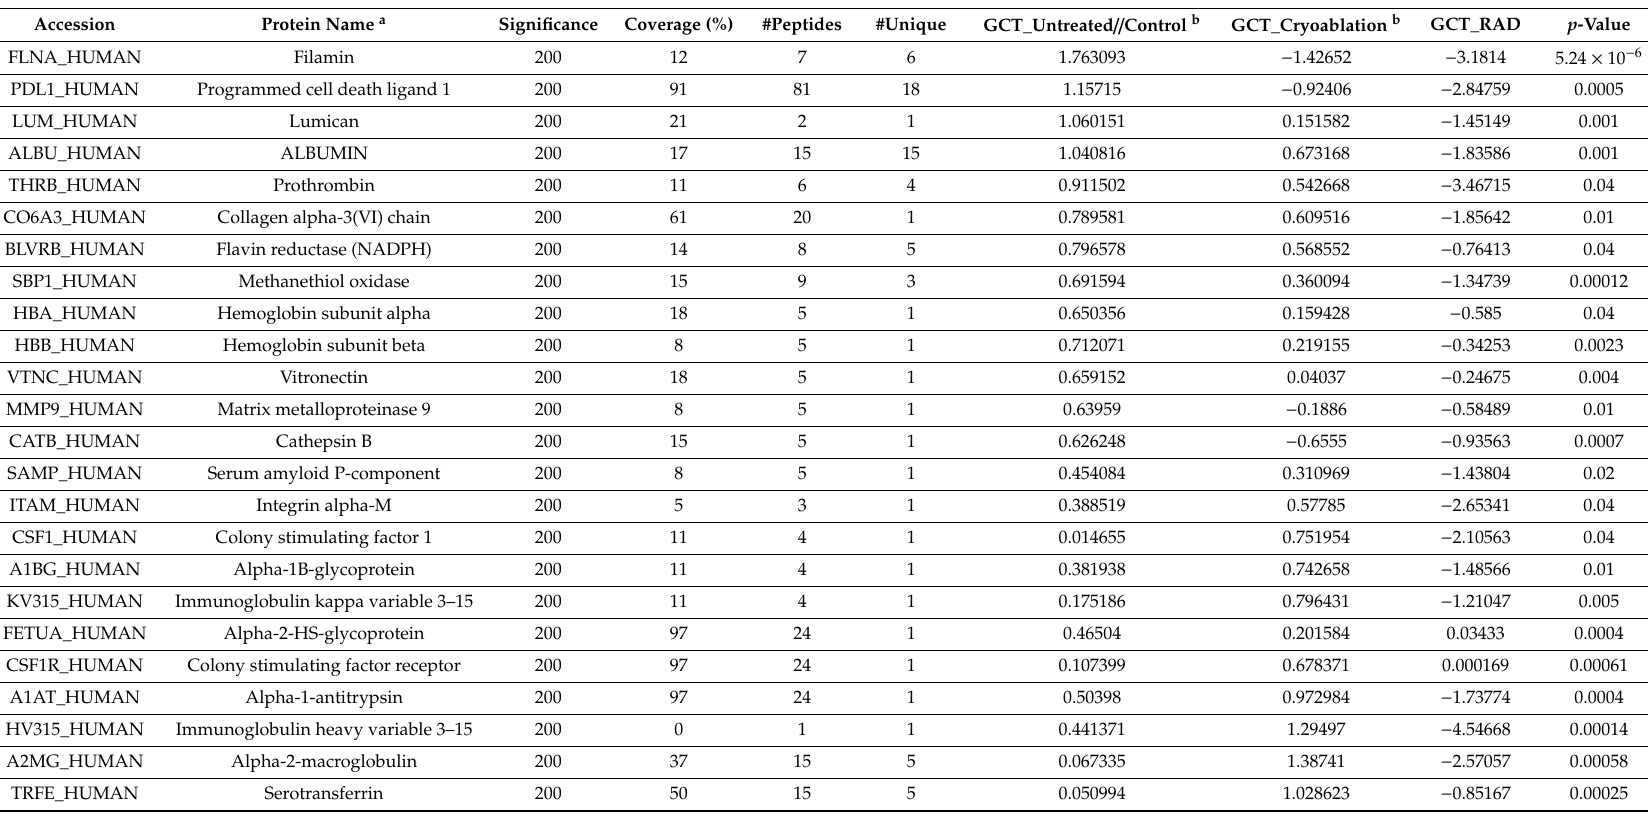
Table 1. Elevated levels of proteins identified from untreated // control giant cell tumor of bone compared to cryoablation and irradiation